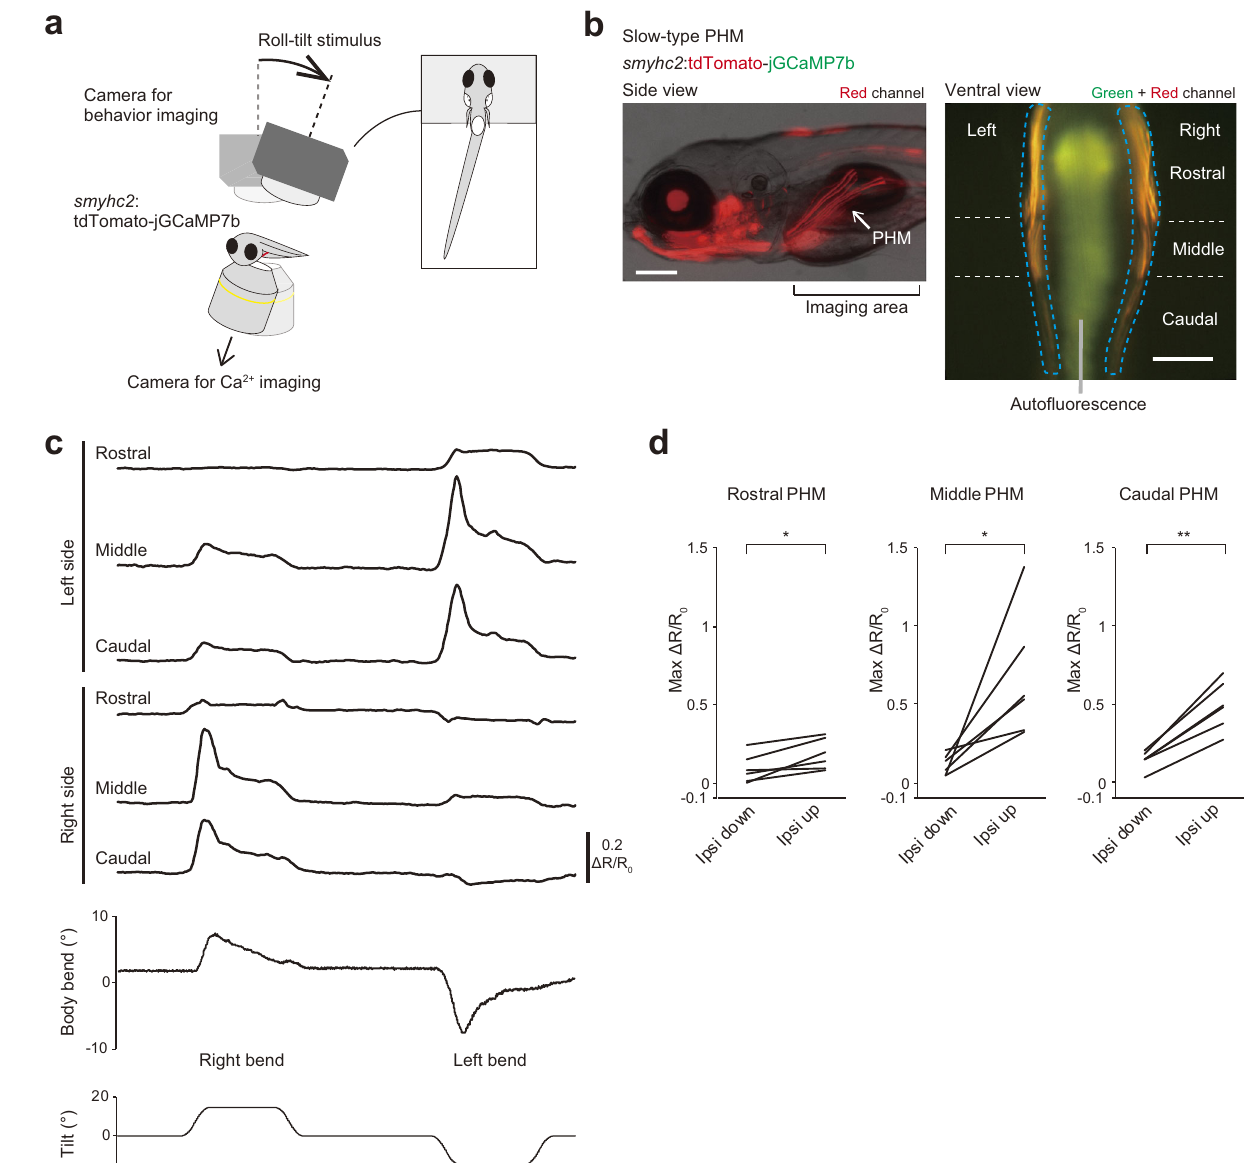
Fig. 8 | Ca 2+ imaging of slow-type PHMs during roll tilts. a Schematic showing simultaneousimagingofCa 2+ inPHMsand fi shbehaviors. b Fluorescenceimagesof Tg( smyhc2 :tdTomato-jGCaMP7b) fi sh at 6 dpf. Left: lateral view. Red fl uorescence and transmitted light images are merged. Right: ventral view of the area around PHMs( “ imagingarea ” intheleftpanel).Rostralistothetop.Greenandredchannels are merged. PHMs are bilaterally located (dashed blue lines). They consist of the following three segments: rostral, middle and caudal segments. Auto fl uorescence